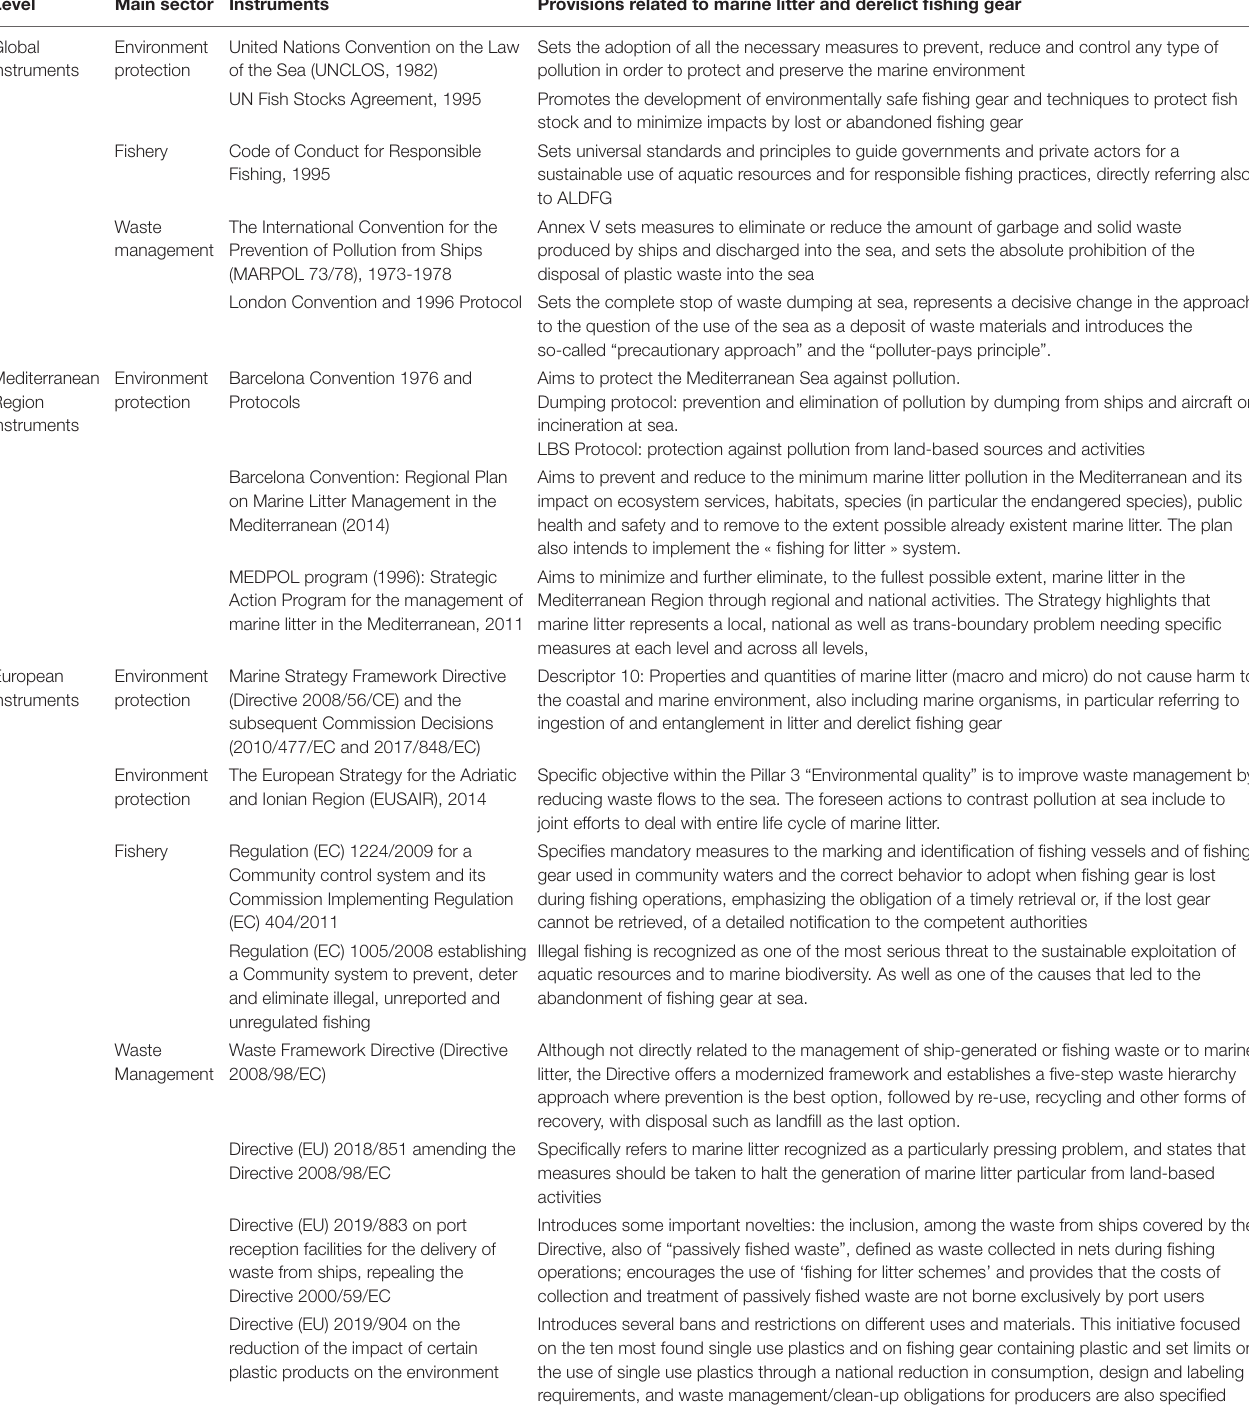
TABLE 1 | List of the main strategies and regulations developed to address marine litter issue at international, regional, and EU levels.